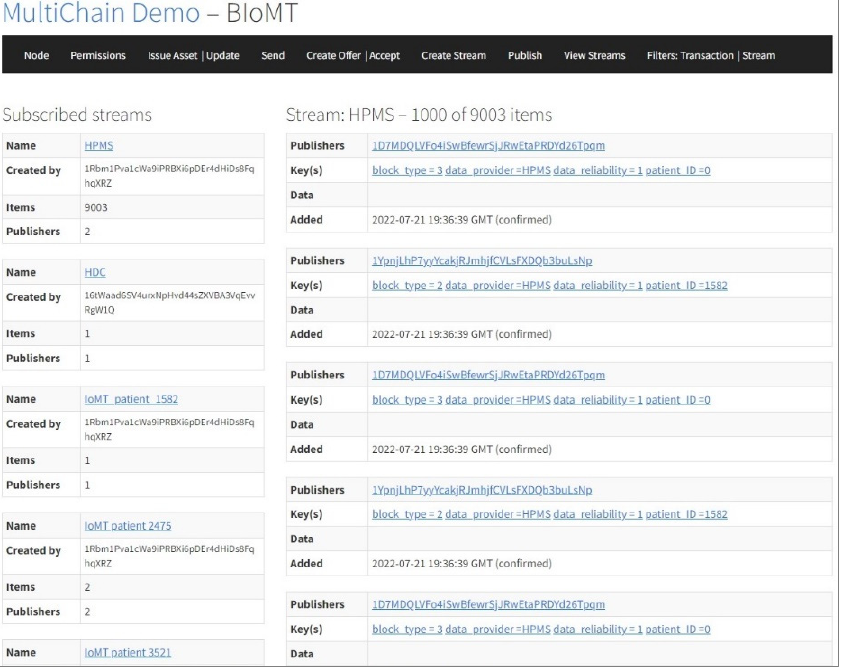
Figure 7. Selected streams with publishers (addresses) from the implemented blockchain.